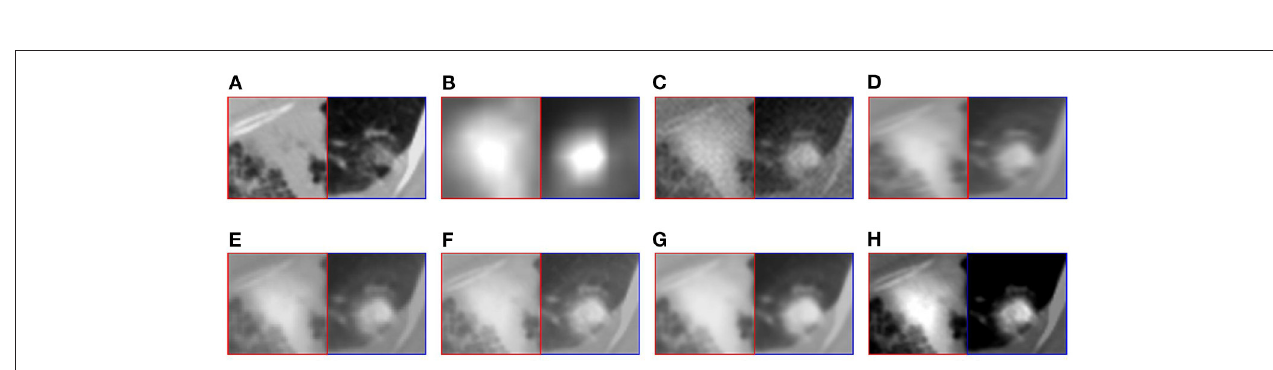
FIGURE 6 | The detail of fusion results of patient A. (A) CT; (B) PET; (C) AD; (D) GF; (E) PAPCNN; (F) MCFNET; (G) IFCNN; (H) OURS.